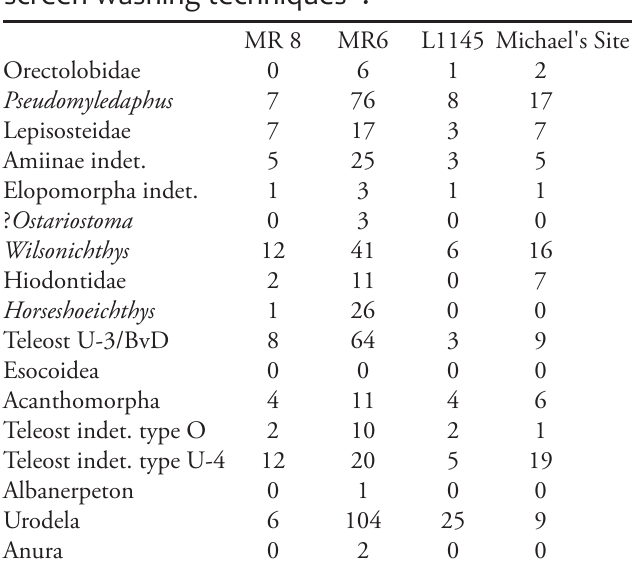
Table 1. Counts of centra of fishes and amphibians from four localities in the Milk River Formation sampled by through the use of underwater screen-washing